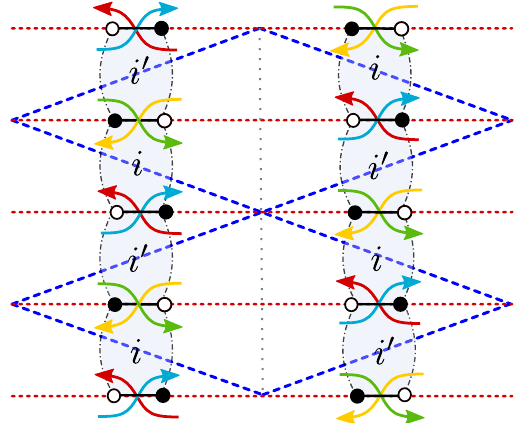
Figure 19. Faces with edges on top of the fixed line at different copies of the unit